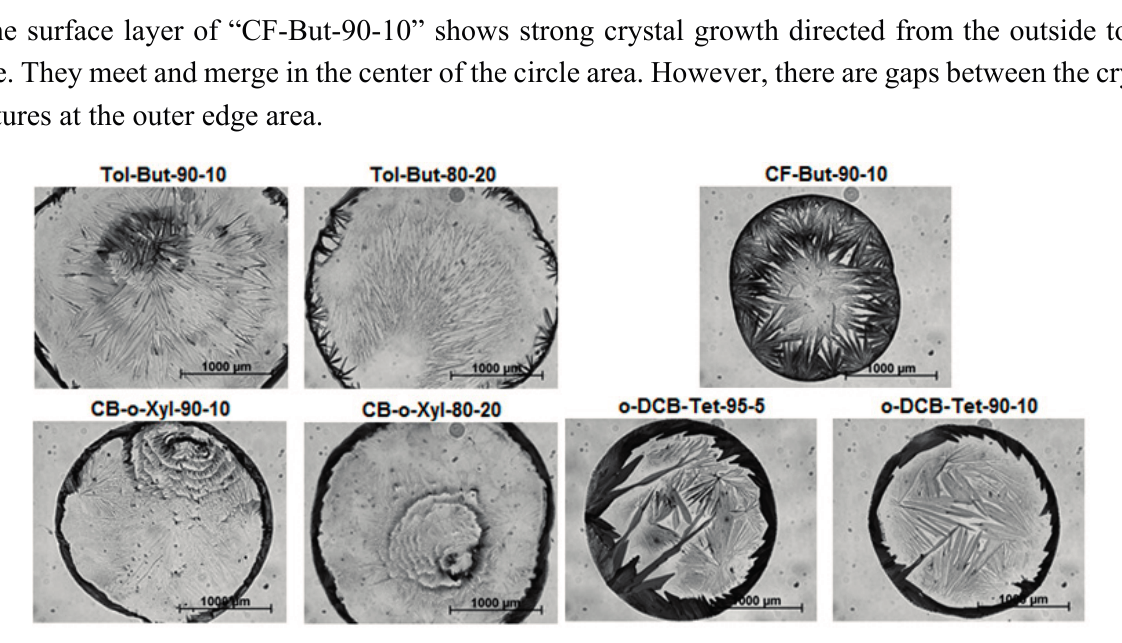
Figure 3. Bright field microscope images of the drop crystallization of the shortlisted solvent mixtures as specified in Table